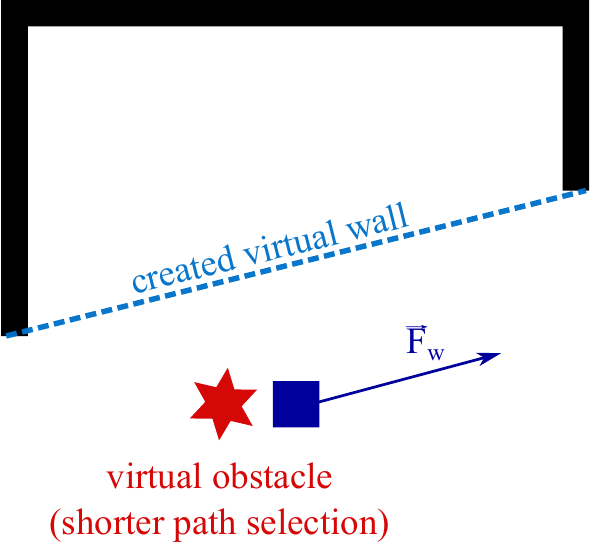
Figure 5. Naive shorter path selection.